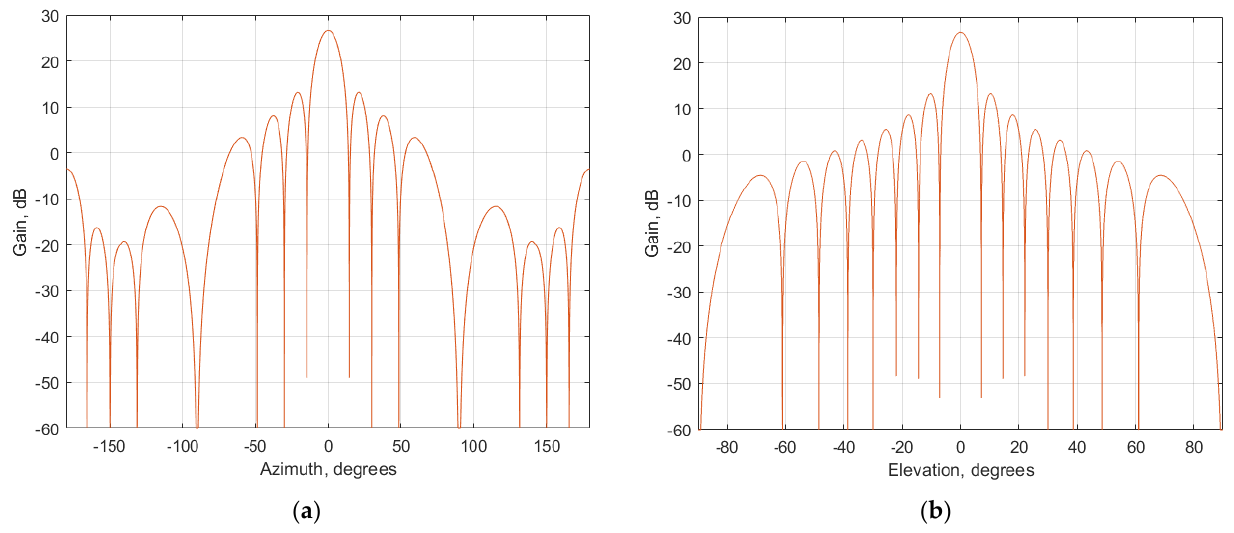
Figure 4. Antenna pattern of urban 5G NR BS ( a ) Horizontal plane; ( b ) Vertical plane.